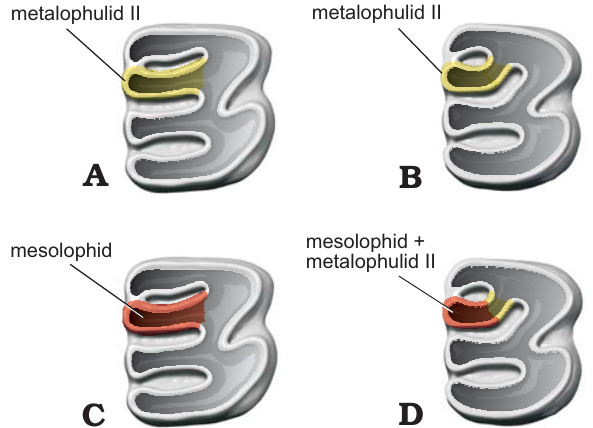
Fig. 1. Hypotheses of correspondences for most anterior lophids of tetralo- phodont lower molars of octodontoids, after Candela and Rasia (2012: fig. 6E, F) ( A , B ) and Verzi et al. (2014) ( C , D ). A . Second lophid homologued to the metalophulid II. B . Second lophid homologued to the metalophulid II, and connected to the metalophulid I. C . Second lophid homologued to the mesolophid, identified in certain octodontoid taxa (see text). D . Second lophid corresponding to the mesolophid + metalophulid II, forming a com- plex crest (see text).Yellow and red colors indicate different homologies proposed for the second lophid in Octodontoid lower